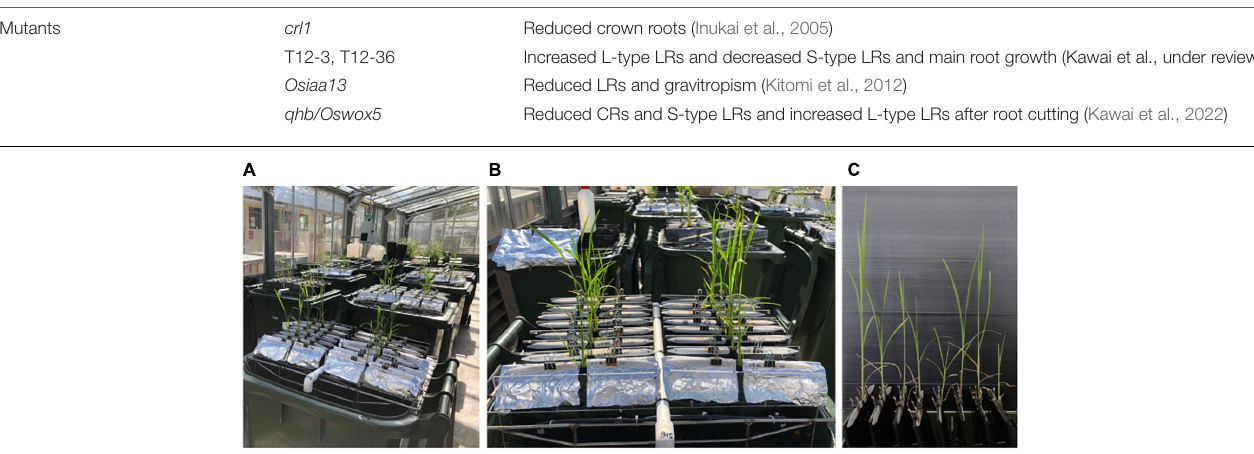
FIGURE 1 | (A) Rice seedlings grown in a semihydroponic phenotyping platform. (B) Close up of plants in the bin. (C) Shoots from the side.